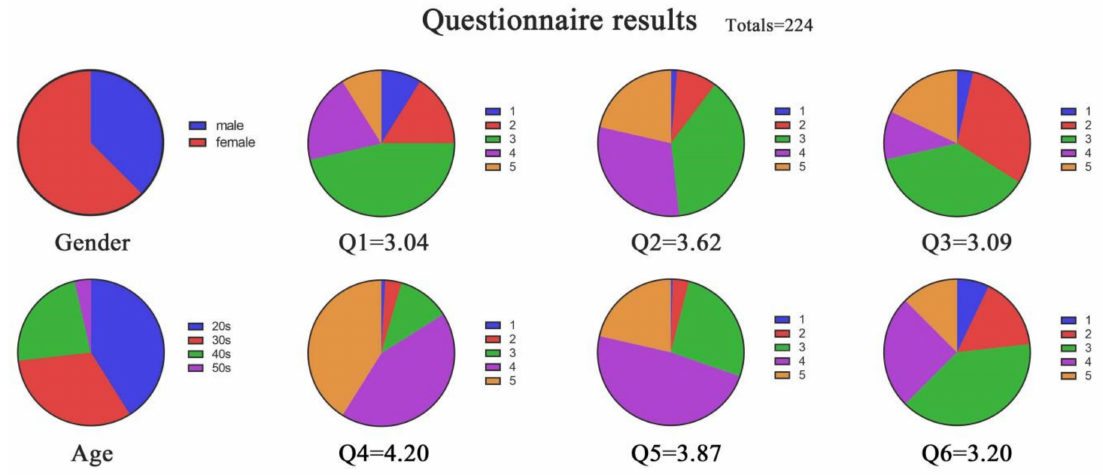
Figure 7. Questionnaire